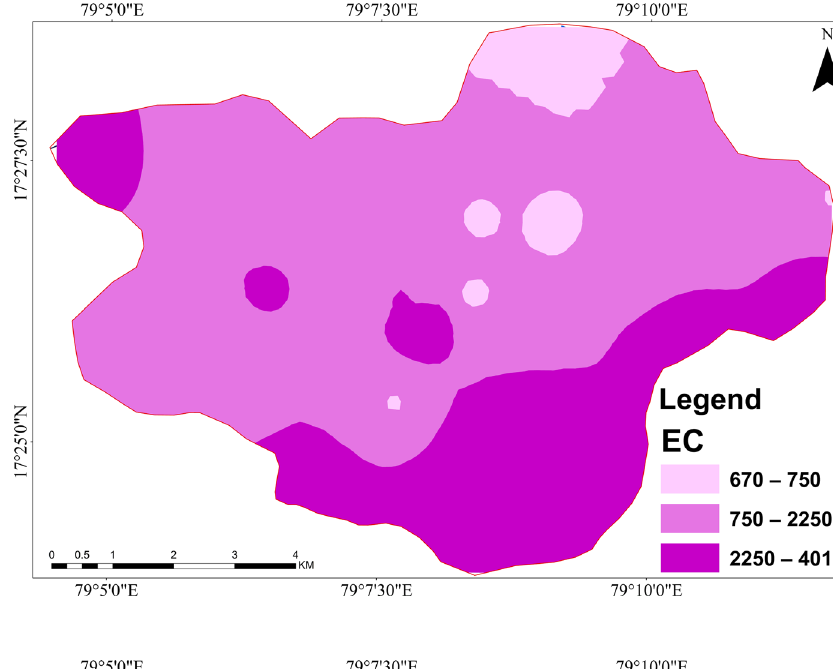
Fig. 4 Spatial distribution map of TDS in Mothkur region, Telangana State, South